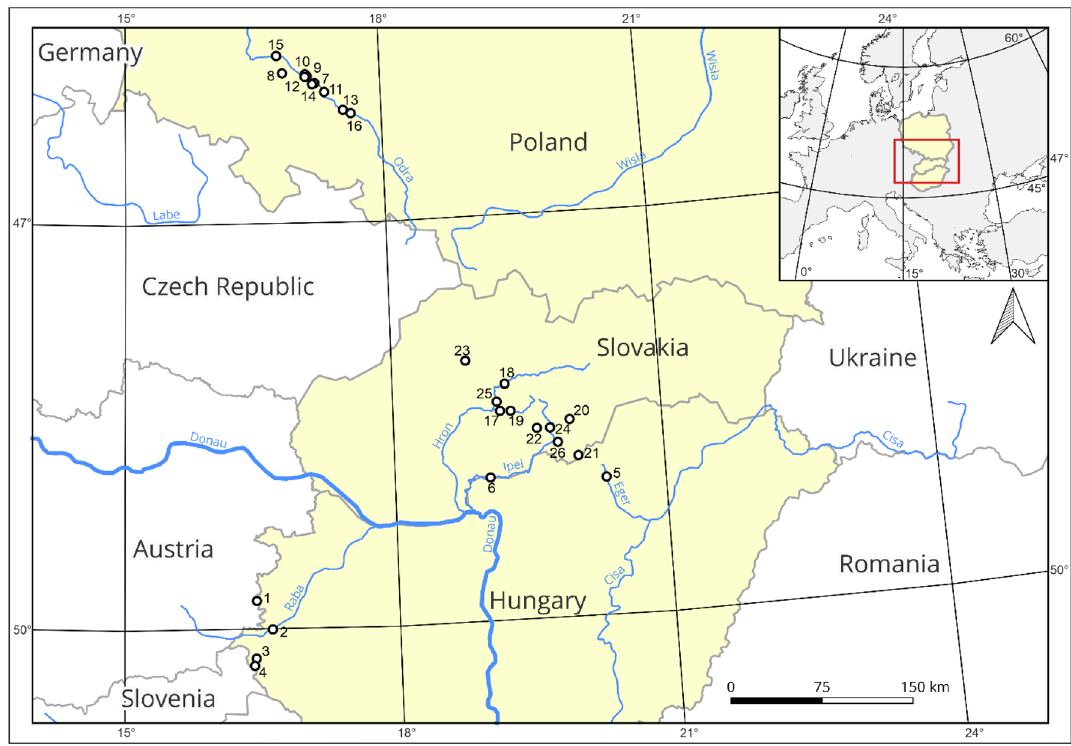
Figure 1. Location of Carex buekii collection sites in Poland, Slovakia and Hungary. The map was made in QGIS version 3.22 available at https:// qgis.